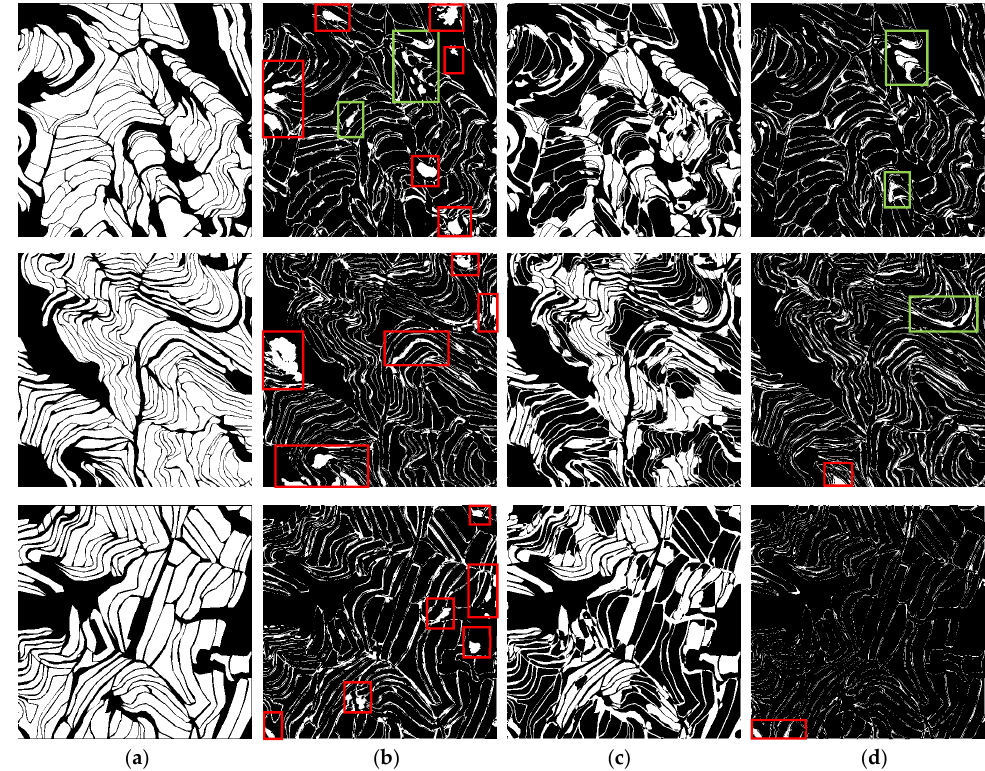
Figure 14. Difference images for the three methods in the three test areas. ( a ) True labels; difference images for ( b ) direct training methods, ( c ) transfer learning strategy 1, and ( d ) transfer learning strategy 2. The top, middle, and bottom rows are the difference images for test areas 1, 2, and 3, respectively. The white areas are the parts where the predicted results are different from the real labels. The black areas are the parts where the predicted results are the same as the real